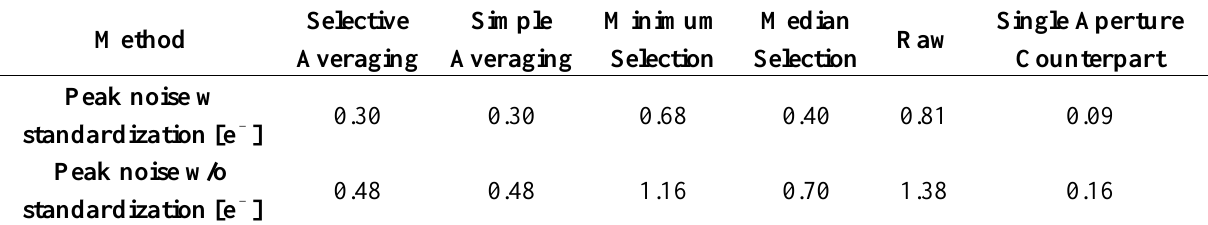
Table 2. The peak of noise histogram in each method (dark condition).